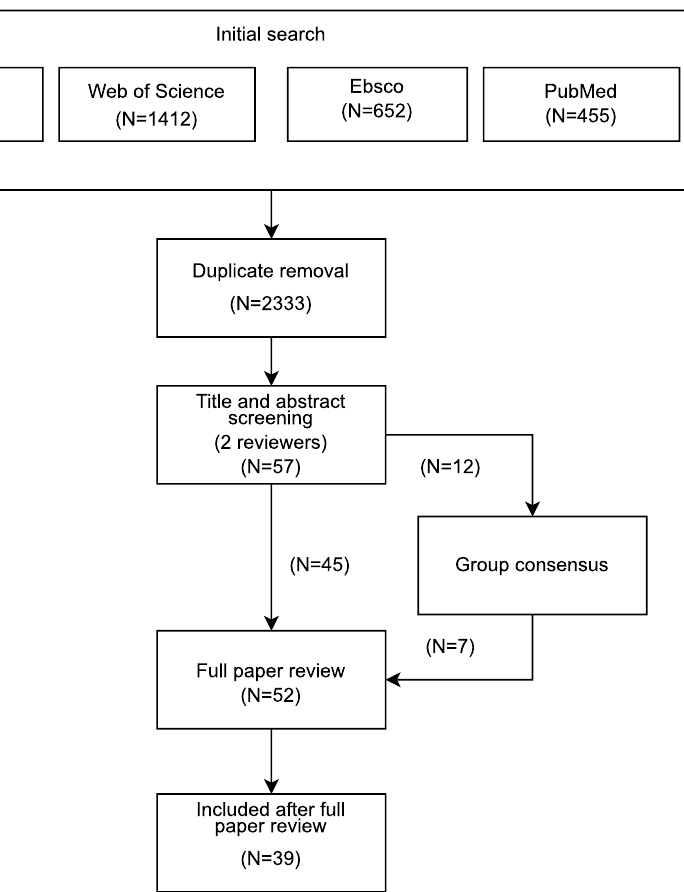
Figure 1. Flowchart of the screening